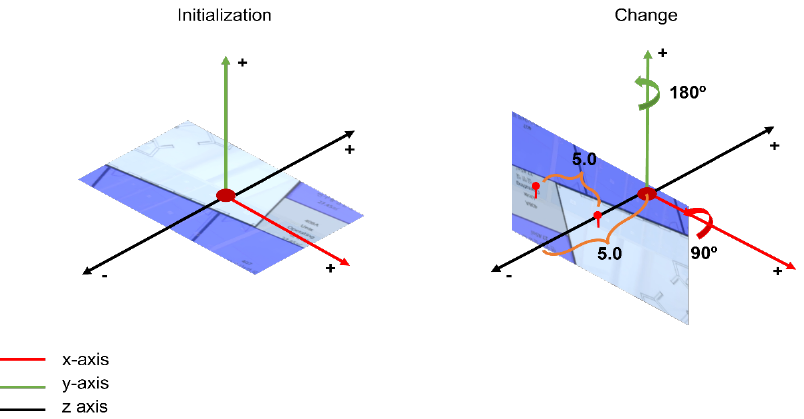
Figure 6. The user’s location is displayed as an icon on the indoor map.